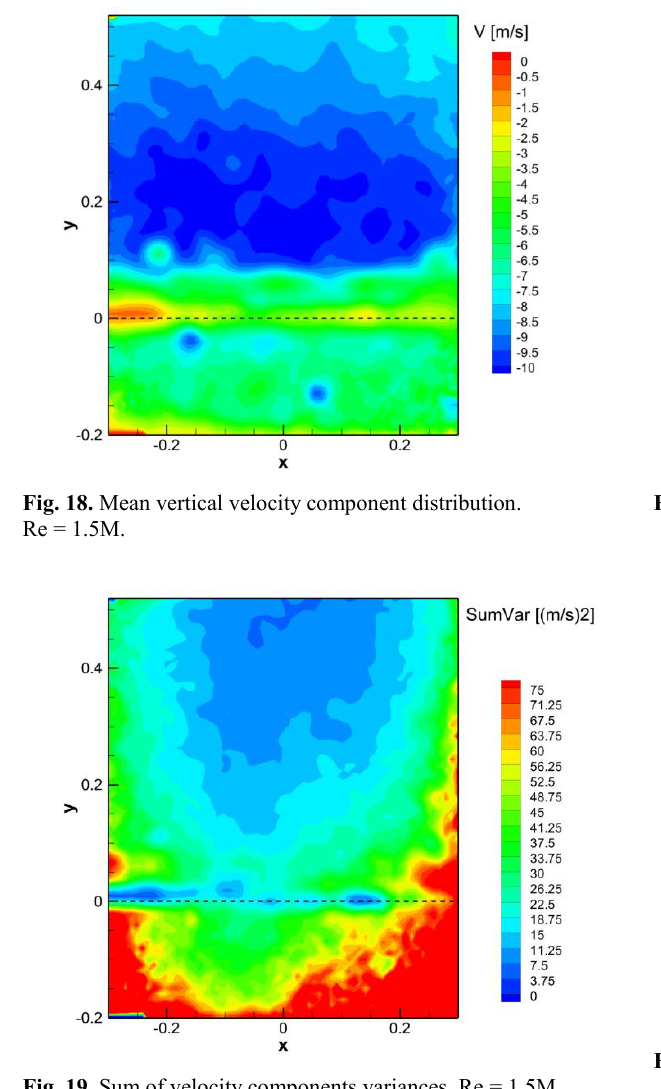
Fig. 19. Sum of velocity components variances. Re = 1.5M. The observations on velocity distributions comply with those given above for lower Reynolds number.